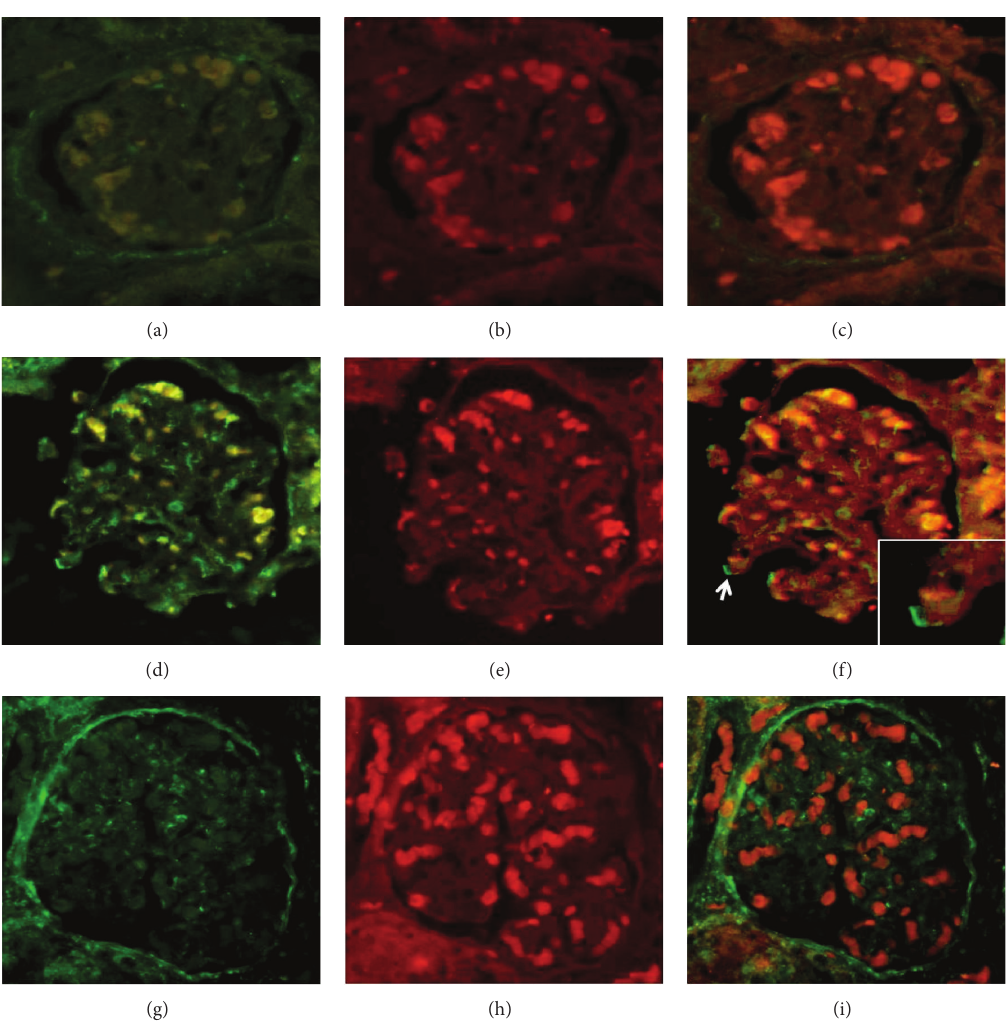
Figure 7: Double fluorescence assay showing apoptotic membranes of glomerular cells with annexin stained in green (a, d, and g) and intracellular autoantigens stained by Texas red (b, e, and h). The overlap merge is shown on the right (c, f, and i). In the upper panel (a, b, and c), a control without metallic ions is shown, characterized by the absence of annexin and the faint presence of intracellular Ro protein. The sample in the middle panel (d, e, and f) was collected from an animal treated with CuSO 4 and shows in the overlap fine linear traces in green of apoptotic membranes of podocytes (arrow and the square magnification) close to the translocated Ro autoantigens. The inferior panel corresponds to an experimental animal treated with AgNO 3 . Interestingly, annexin staining is broadly distributed along the membranes of the Bowman capsule and mesangial area coincident with the Sm